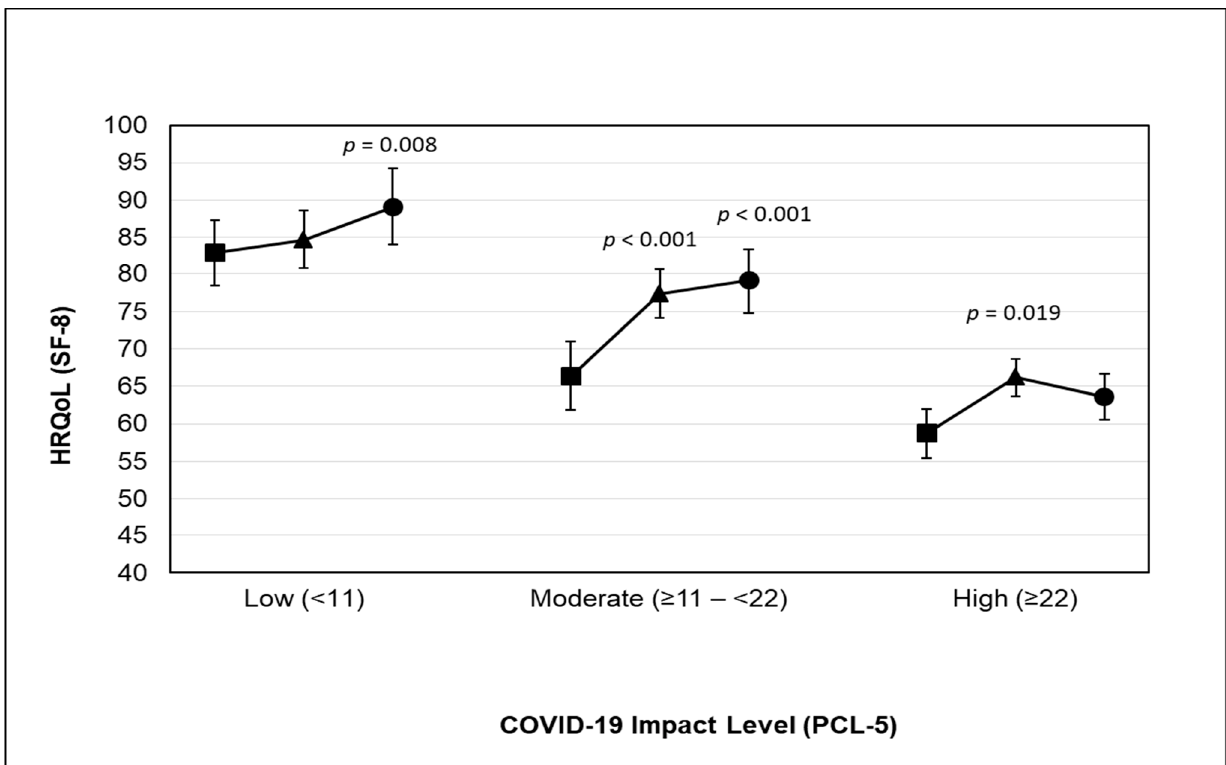
Figure 1. Predicted marginal mean HRQoL for COVID-19 impact among adults participating in physical activity (( ■ Inactive: reporting <600 MET-min/week), ( ▲ sufficiently active: reporting ≥ 600 MET-min/week), and ( ● very active: reporting ≥ 3000 MET-min/week)). The model was adjusted for age, sex, body mass index, ethnicity, region of residence, social status, education, employment, income, smoking status, and chronic diseases. Abbreviations: CI, confidence interval; HRQoL, health-related quality of life; PCL-5, posttraumatic stress disorder checklist; SF-8, short form-8 item.